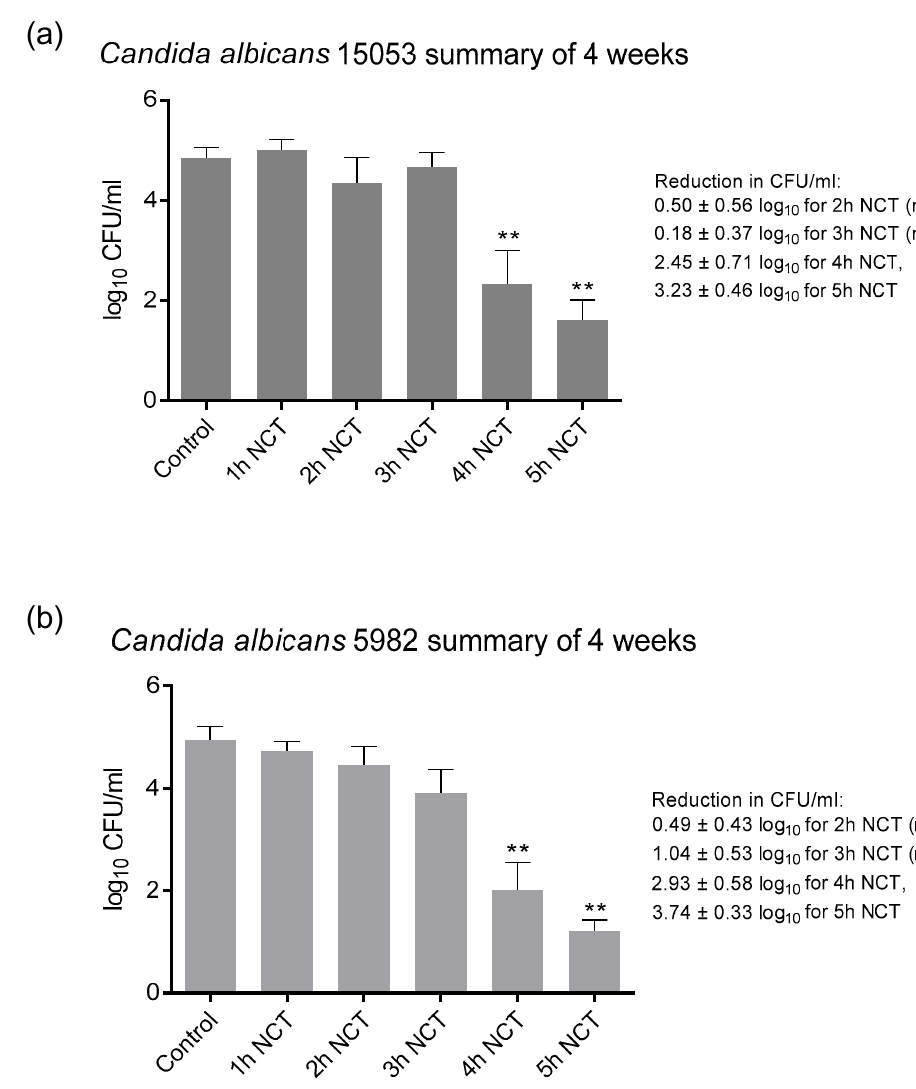
Figure 6. Fungicidal activity of 1% NCT at pH 7 and 37 °C against biofilms of C. albicans ATCC 15053 ( a ) and CBS 5982 ( b ) grown for 4 weeks. Weekly evaluation by quantitative killing assays. Summary of all values of NCT and controls. Mean values ± SEM, n = 9–12 values each from 2–3 independent experiments; ** p < 0.01 versus control; n.s.: not significant.